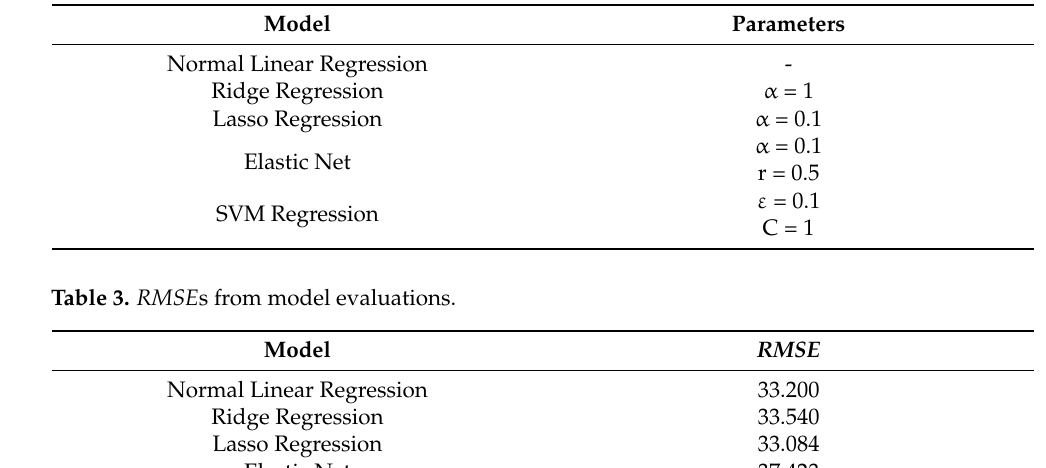
Table 2. The ML model parameters.